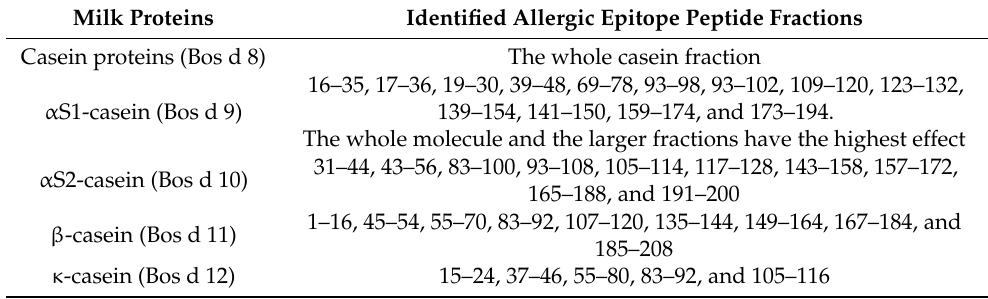
Table 7. The identified allergic epitopes of the major cow casein